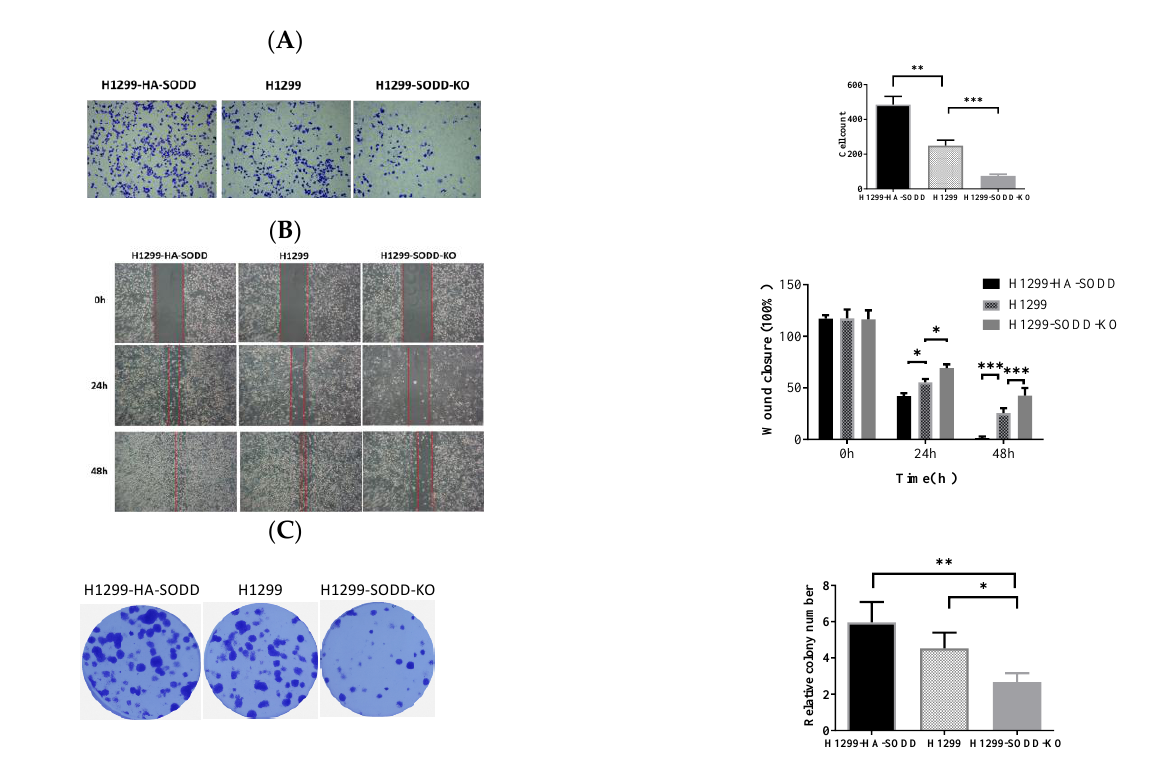
Figure 3. SODD promotes the migration and invasion of H1299 cells. ( A ) Transwell assay: HA-SODD H1299, SODD knockout H1299, and H1299 cells migrating through the Transwell chamber after 48 h were counted. ( B ) Wound healing assay. The represented images of the relatively migrated speeds of HA-SODD H1299, SODD knockout H1299, and H1299 cells at 0 h, 24 h, and 48 h, respectively. ( C ) The typical image of colony formation in HA-SODD H1299, SODD knockout H1299, and H1299 cells (* p < 0.05, ** p < 0.01, *** p < 0.001 vs. control).